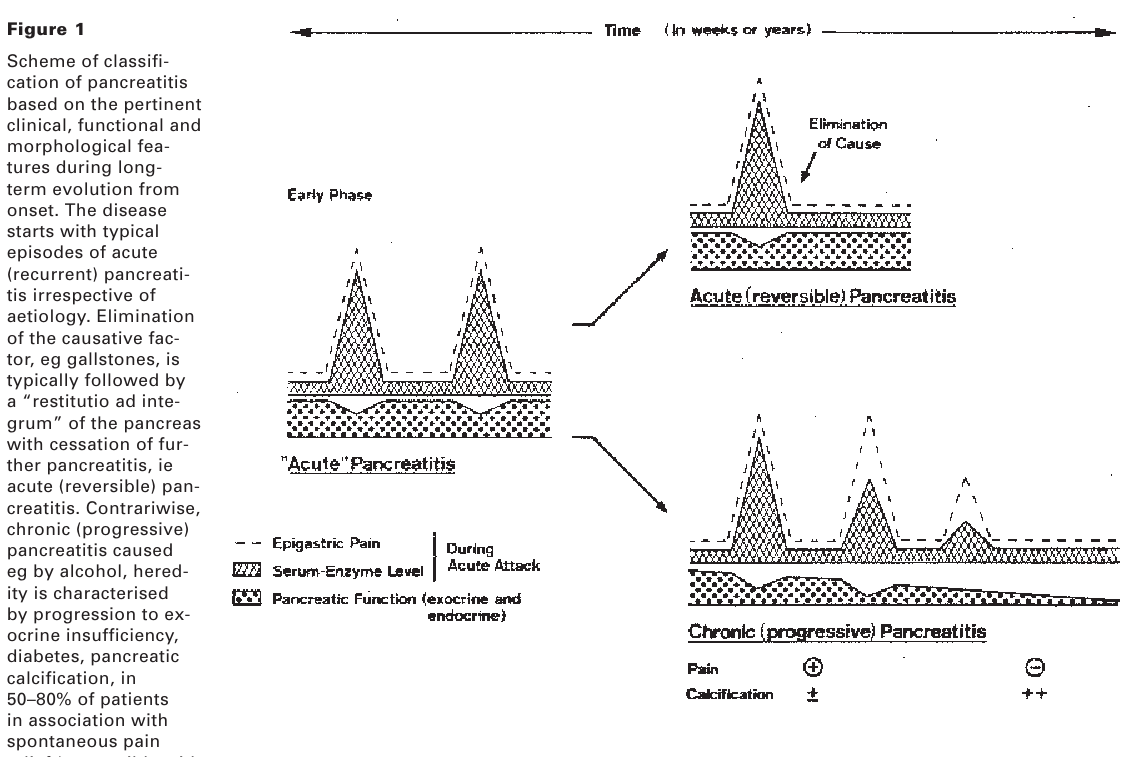
Figure 1 Scheme of classifi- cation of pancreatitis based on the pertinent clinical, functional and morphological fea- tures during long- term evolution from onset. The disease starts with typical episodes of acute (recurrent) pancreati- tis irrespective of aetiology. Elimination of the causative fac- tor, eg gallstones, is typically followed by a “restitutio ad inte- grum” of the pancreas with cessation of fur- ther pancreatitis, ie acute (reversible) pan- creatitis. Contrariwise, chronic (progressive) pancreatitis caused eg by alcohol, hered- ity is characterised by progression to ex- ocrine insufficiency, diabetes, pancreatic calcification, in 50–80% of patients in association with spontaneous pain relief (compatible with “burn-out” of